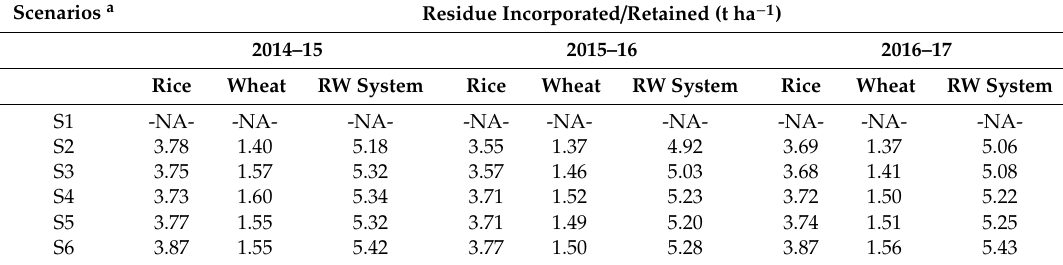
a Refer Table 1 for detail scenario description. NA: Not applicable. S1-Conventional tillage (CT) without residue; S2-CTwithresidue, S3-Reducedtillage(RT)withresidue + Recommendeddoseoffertilizer(RDF);S4-RT / zerotillage (ZT) with residue + RDF, S5-ZT with residue + RDF + green seeker + tensiometer + Information & communication technology + crop insurance and S6- S5 + site specific nutrient